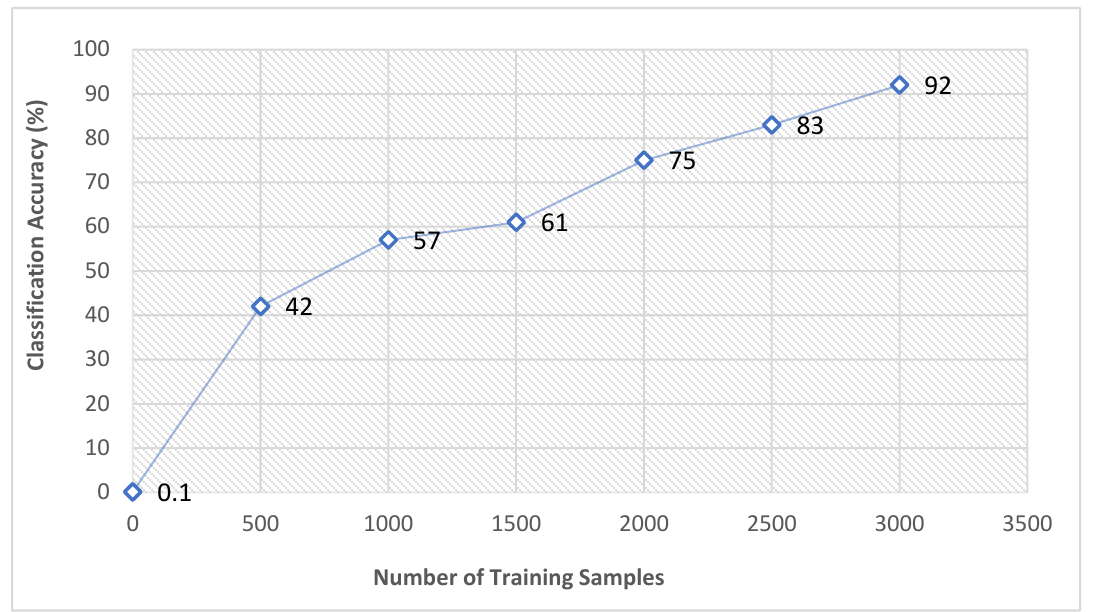
Figure 9. Graph showing classification performance with the number of samples in the training dataset.